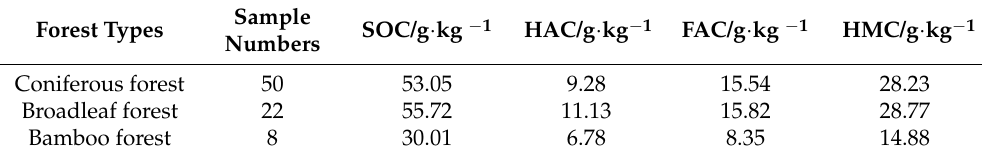
Table 2. Characteristics of soil organic matter composition in different forest